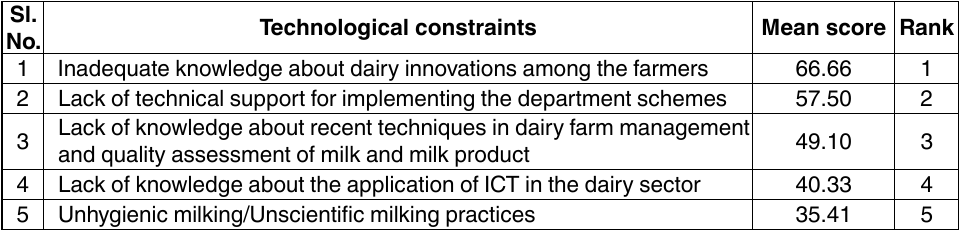
table 3. Technological constraints as perceived by the FEFs of DDD, Kerala sl.